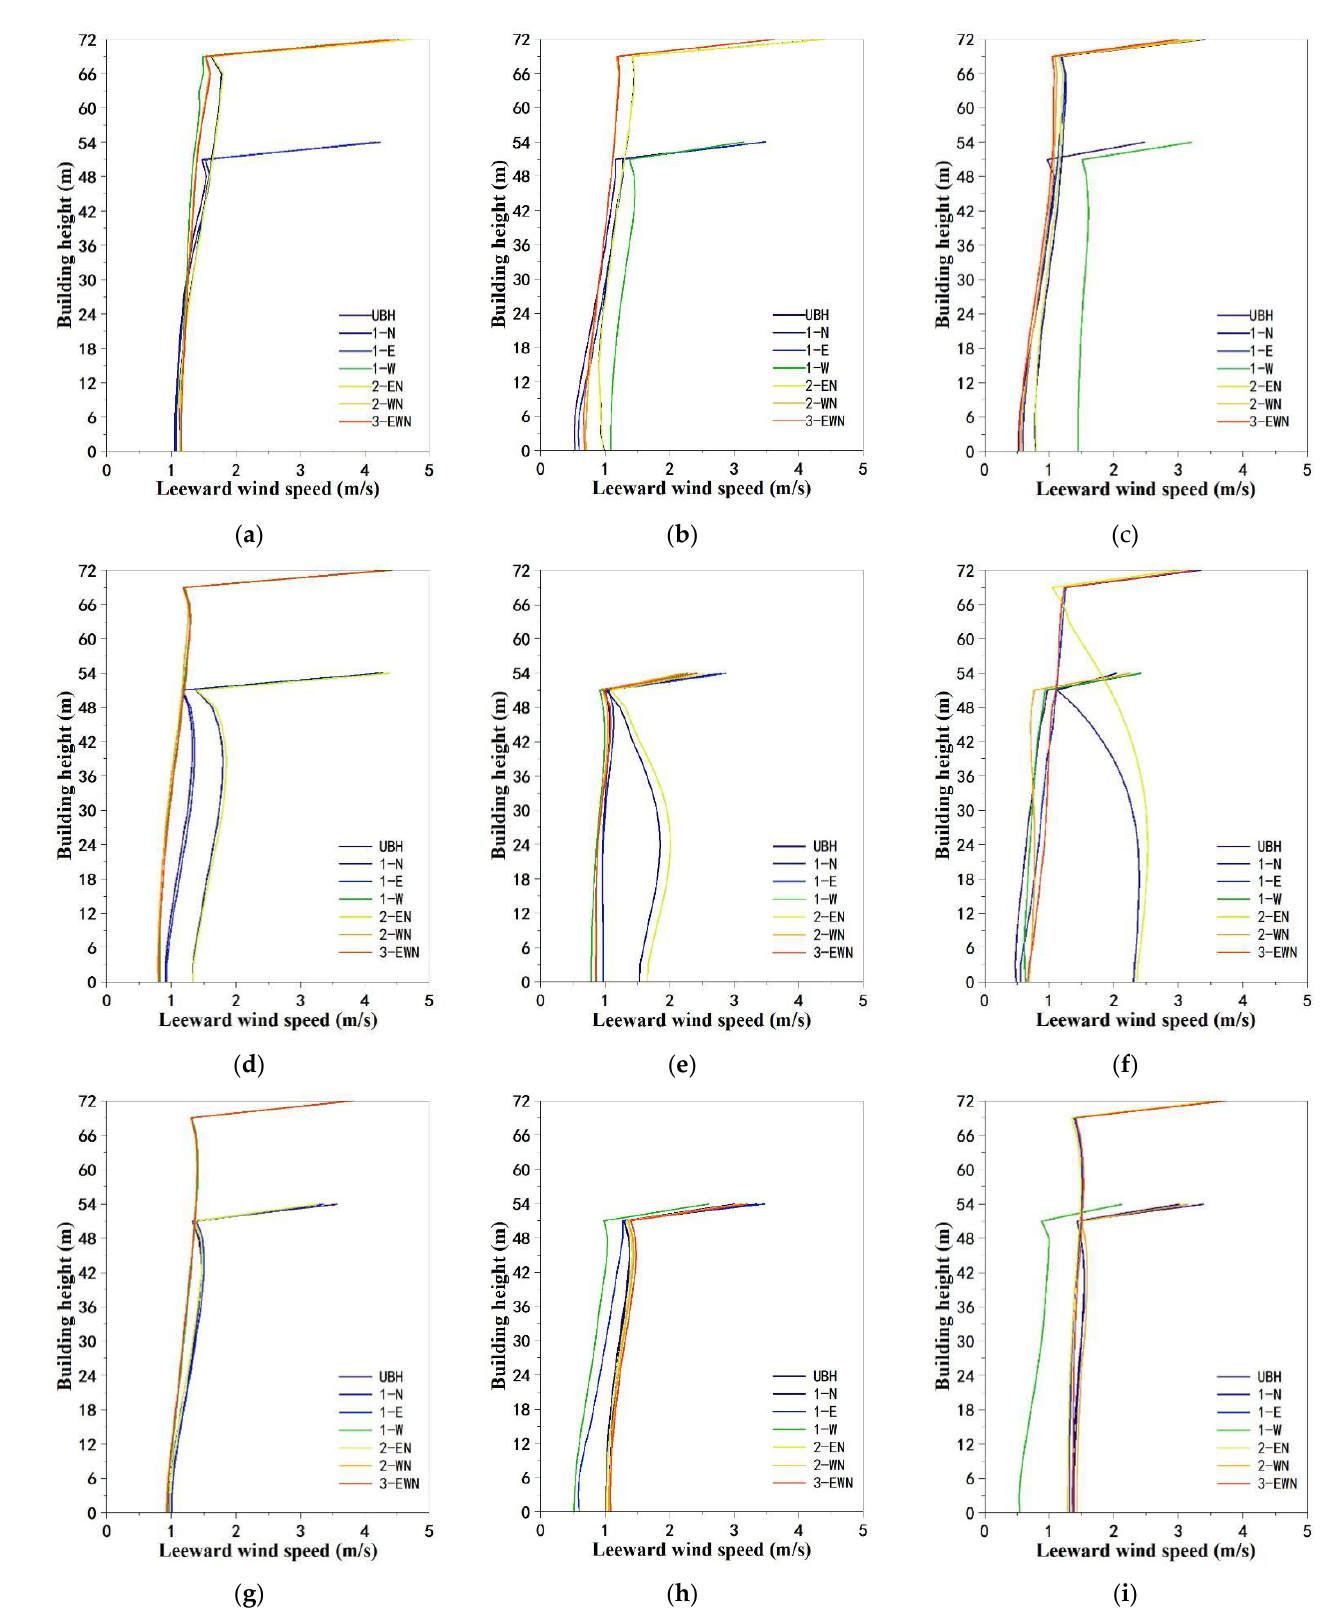
Figure A8. Air velocity on the leeward side of single buildings under seven operating conditions;